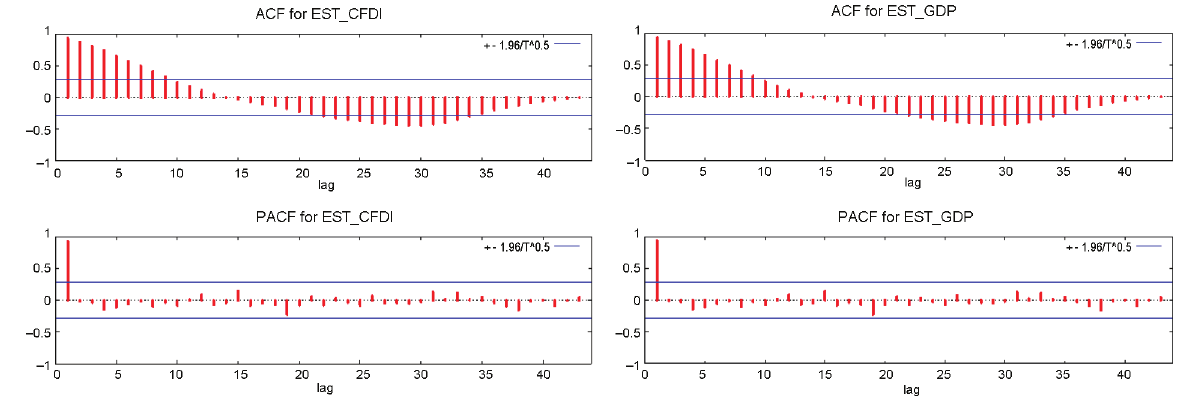
Fig. 9. Plotting the autocorrelation function (ACF) and partial autocorrelation function (PACF) for Estonia’s CFDI and the construction’s contribution to GDP